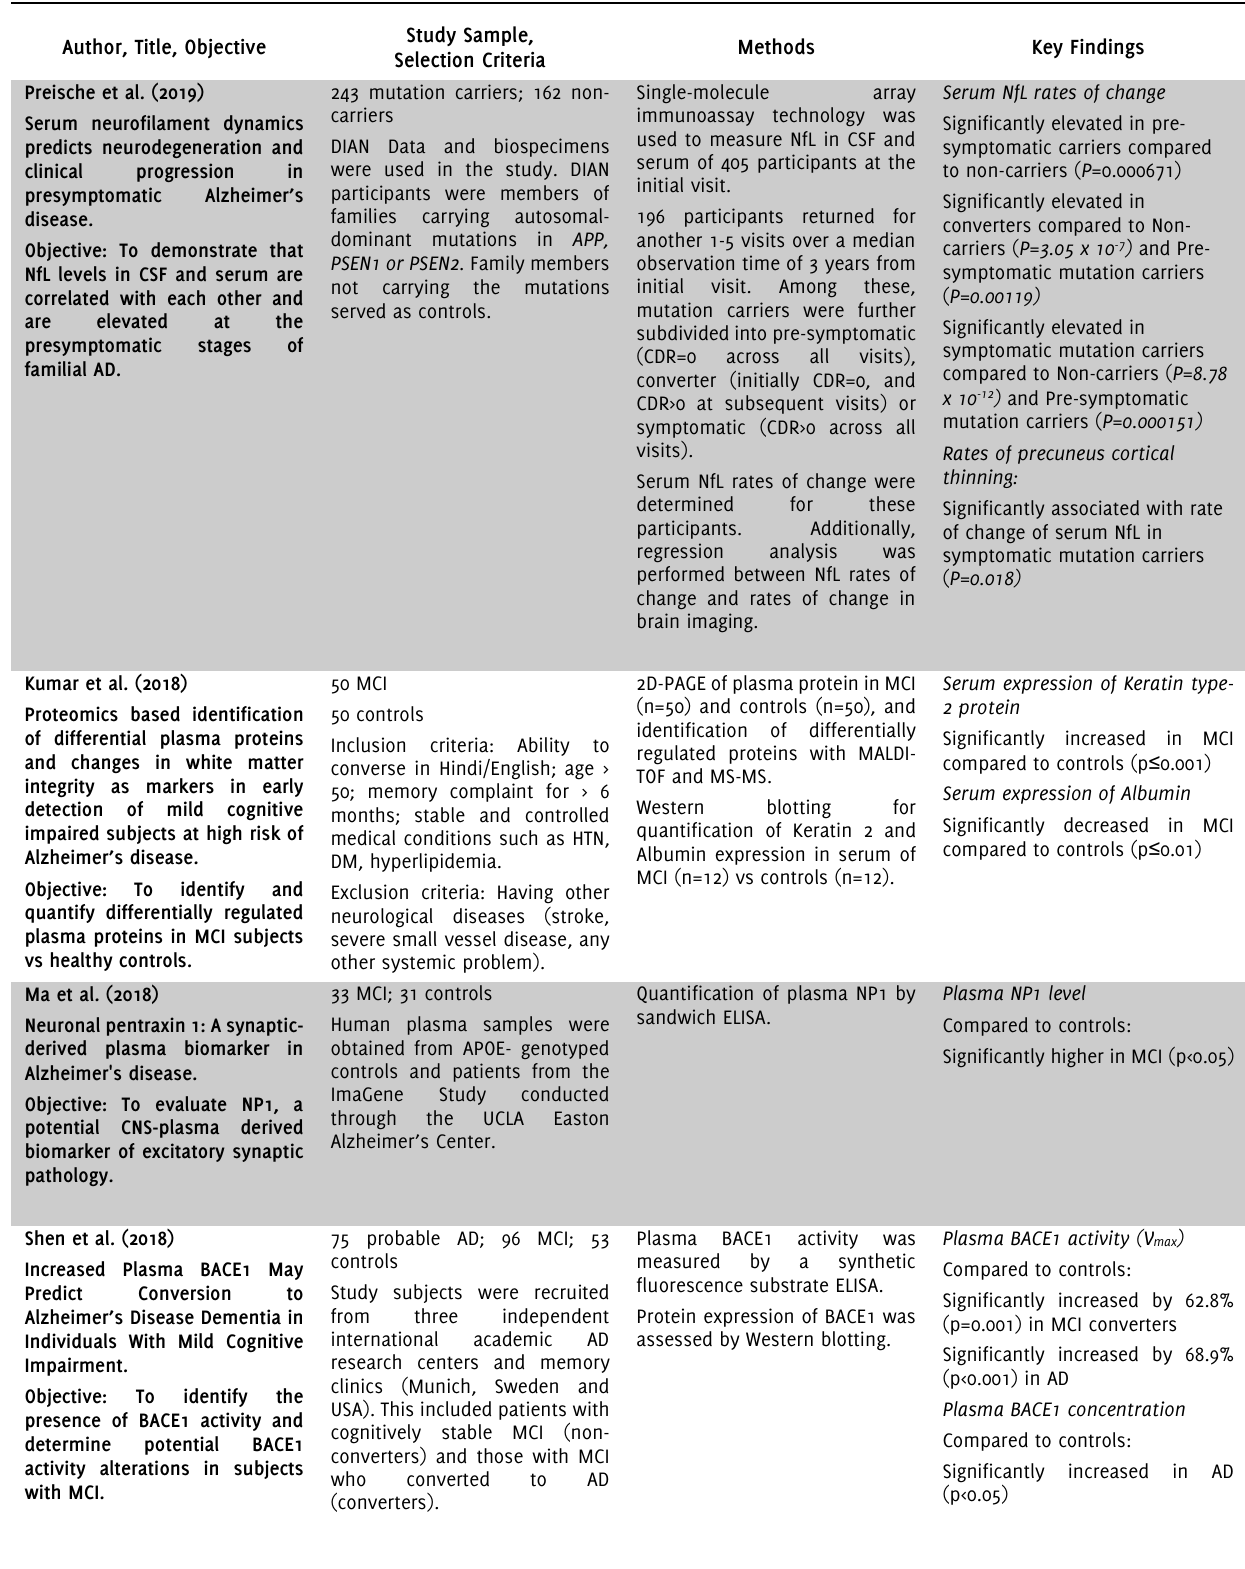
Table 3. Other blood-based protein biomarkers for Alzheimer’s